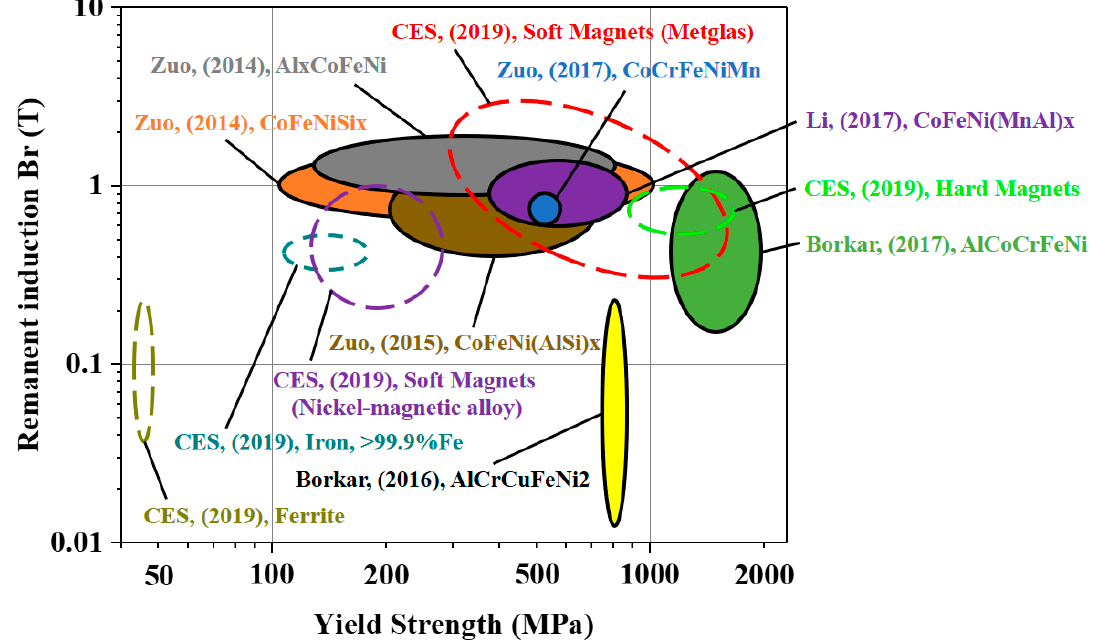
Figure 6. Remanent induction vs. yield strength for conventional alloys (encircled by dashed lines) and HEAs (colored regions encircled by solid lines). (Data taken from [5,27,29,33,43,44,72,76,77,79,80]). The data is from the CES EduPack 2009, Granta Design, Limited, Cambridge, UK, 2009.